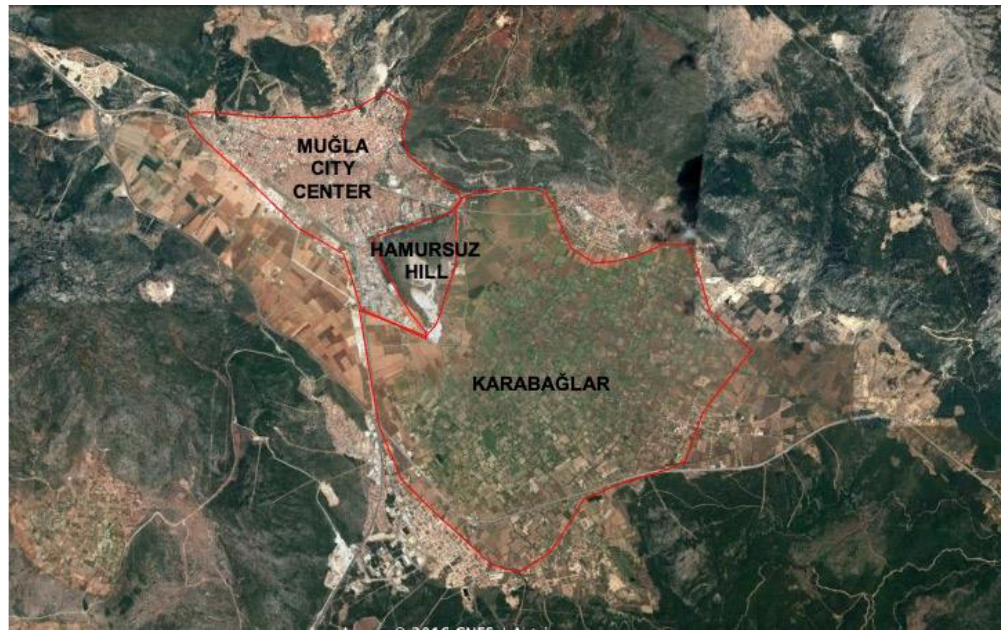
Figure 1 Location of Karabağlar